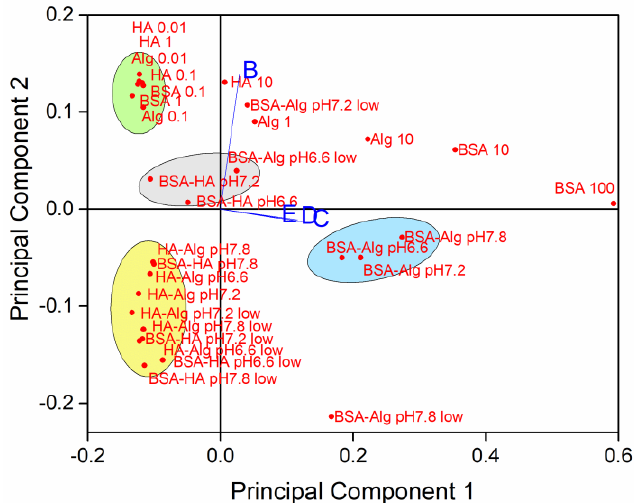
Figure 6. Principal components of sample variability based on NOM type and concentration (indi- vidual NOM given in mg L −1 ; pH 7.8), pH, oxygen saturation (low = 50% saturation) and salinity (B-E; S·0, 10, 20 and 38, respectively).